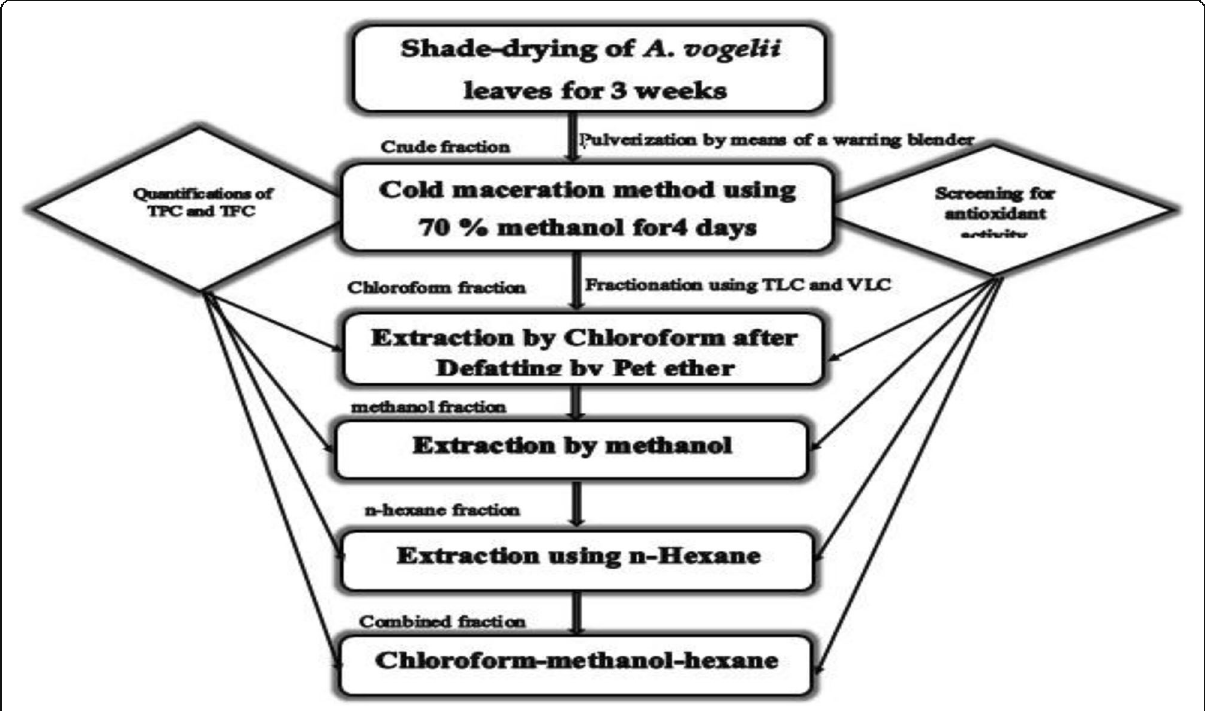
Fig. 1 The order of extraction and fractionation of A. vogelii leaves